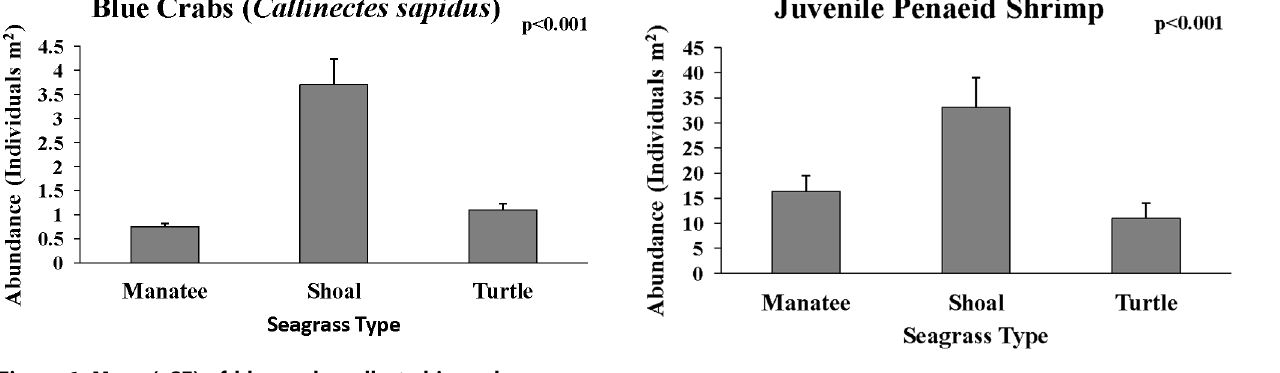
Figure 7. Mean ( + SE) of shrimp in family Penaeidae collected in each seagrass